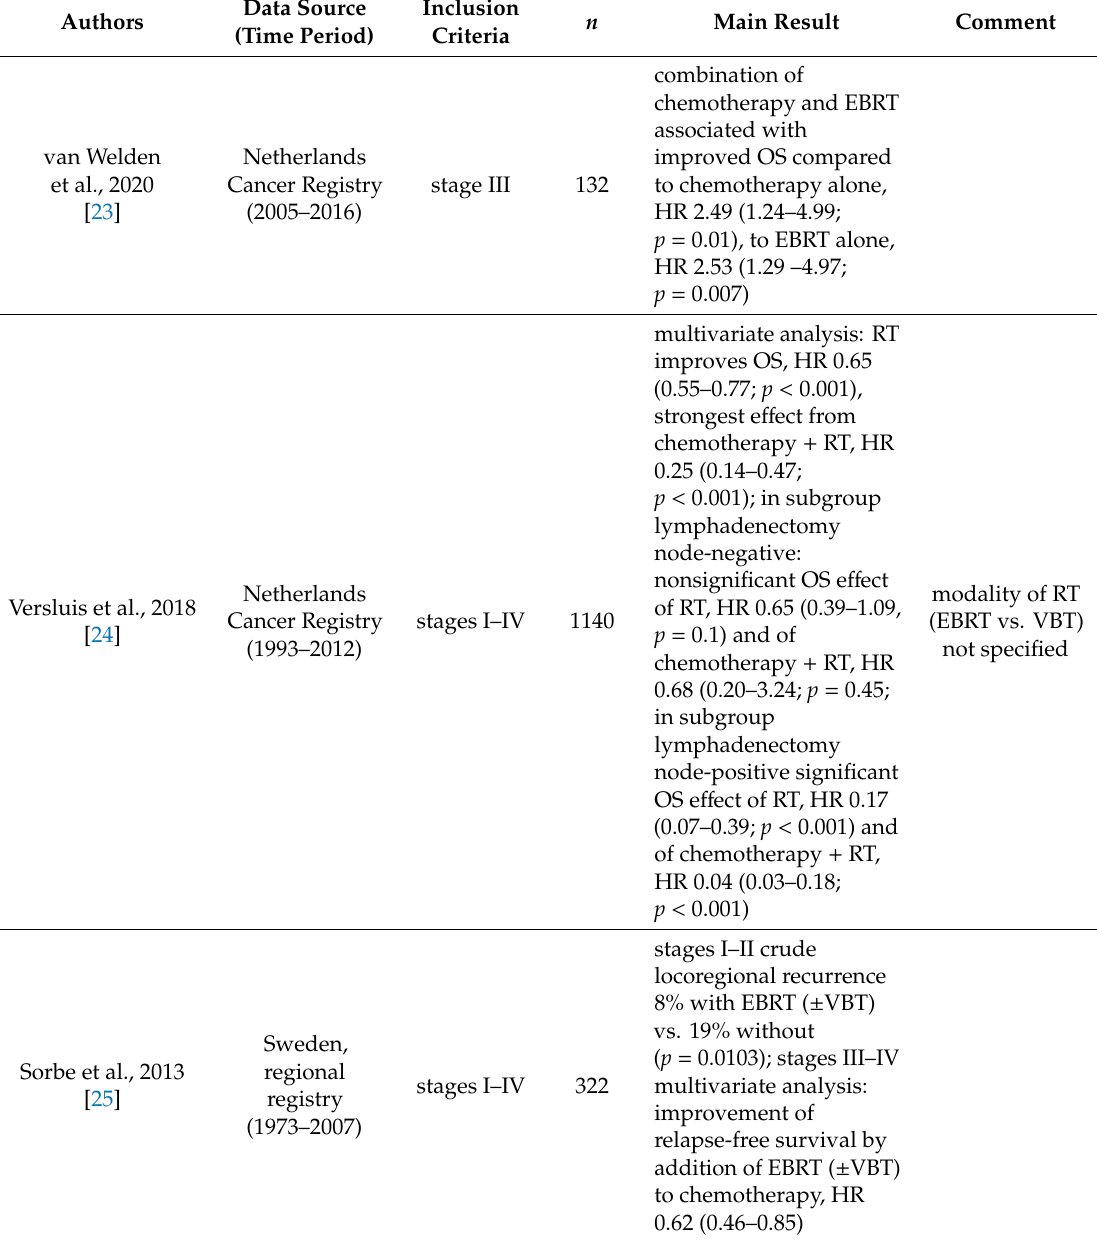
Table 3. Overview of studies of postoperative radiotherapy in uterine carcinosarcoma using data from European cancer registries